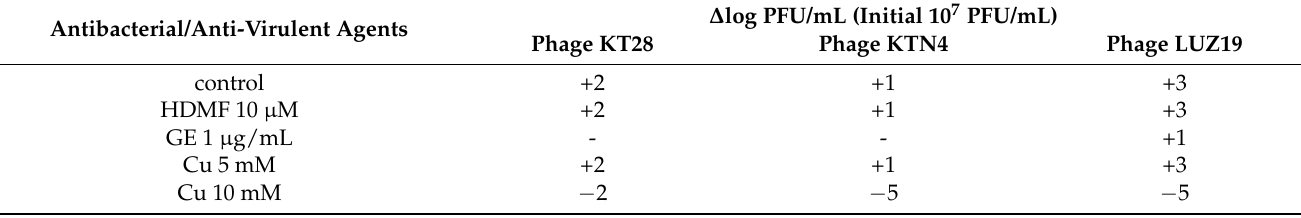
Figure 4. The image of P. aeruginosa PAO1 culture (20 h) treated with Cu 2+ , GE, HDMF and their combination when infected with KT28, KTN4, or LUZ19 phages. Table 1. Phage PFU/mL variation in tenfold change ( ∆ log PFU/mL) after 20 h propagation on bacterial culture supple- Growth curves revealed a strong antibacterial activity of phages used separately and mented with tested agents. with the combination of Cu 2+ and GE in all cases (magenta solid and dash curves), where overlapping effects of Cu 2+ toxicity, GE protein biosynthesis inhibition, and lytic activity of phages were present. The rest of the tested agents and their combinations gave various results in a phage-dependent manner. Phage KT28, alone and in combination with all